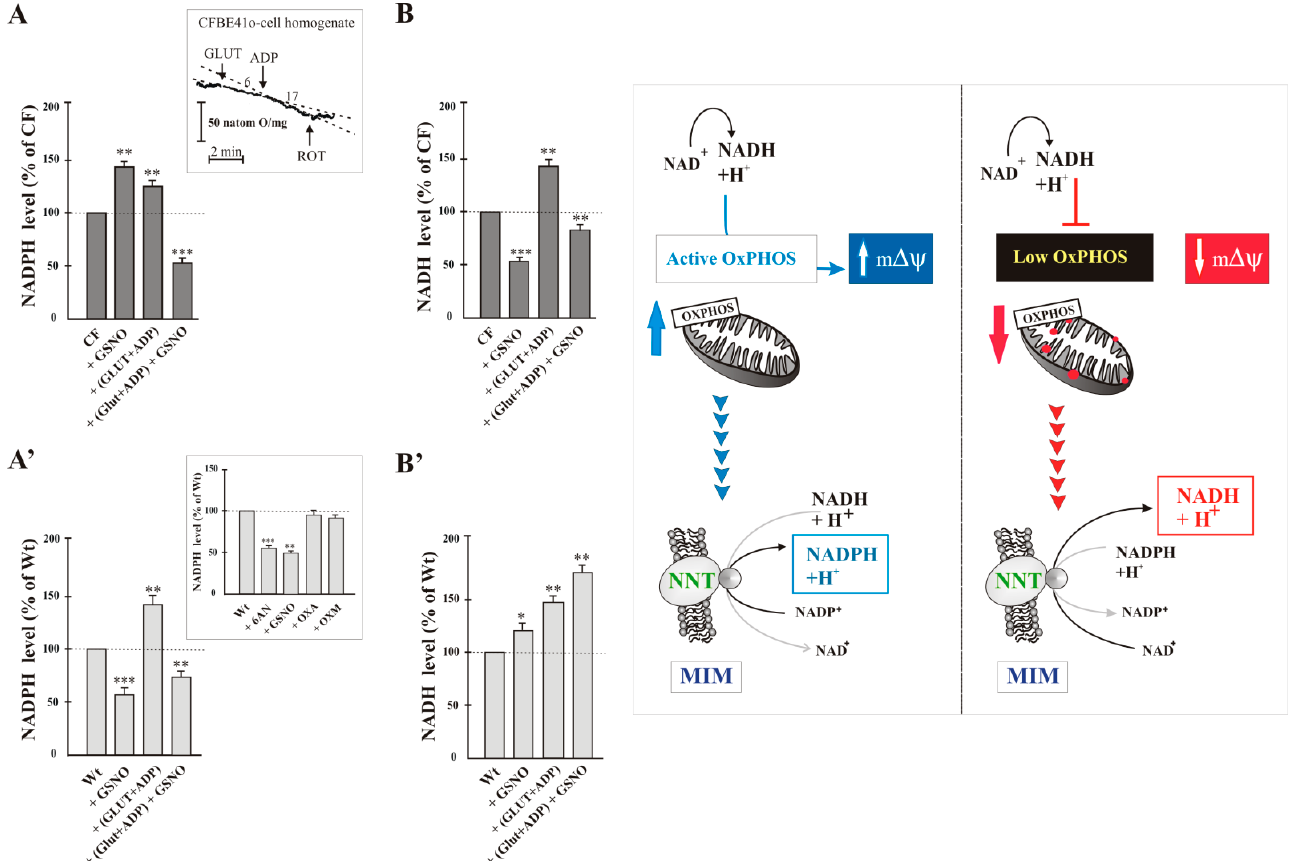
Figure 2. NADPH and NADH levels in airway cells. The amounts of NADPH ( A ‐ A’ ) and NADH ( B ‐ B’ ) were assayed as in [24,25]. Cells were incubated for 15 min in the absence or presence of GSNO (1 mmol/L), GLUT (10 mmol/L), ADP (1 mmol/L). Each level value was expressed as % of control, i.e., sample in the absence of compound, to which value 100 was given. Values were subjected to statistical analysis (Wt, n = 5; CF, n = 5): * p < 0.05; ** p < 0.01; *** p < 0.001 when comparing untreated cells with the cells in the presence of compounds. Inset to ( A ) functionality of mitochondria verified by the ability of (GLUT + ADP) to stimulate oxygen consumption. Inset to ( A’ ) NADPH level measured in Wt cells treated with 6AN (5 mmol/L), GSNO (1 mmol/L), OXA (1 mmol/L), OXM (3 mmol/L).